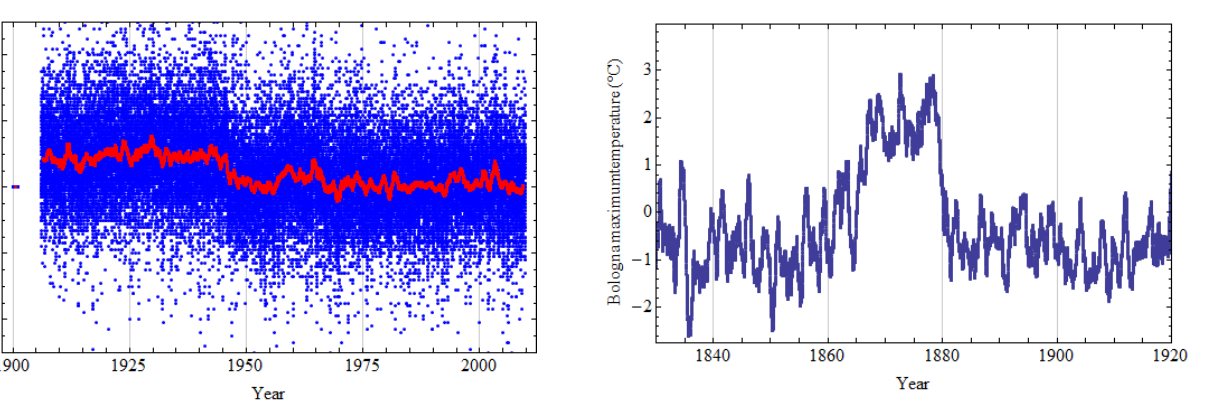
Fig. 1. Blue: difference of mean daily temperatures between the weather stations of Maastricht and DeBilt in the Netherlands. Red: Fig. 1. Blue: Difference of mean daily temperatures between the same data after application of a one-year moving average. weather stations of Maastricht and DeBilt in the Netherlands. Red: Same data after application of a one-year moving average.